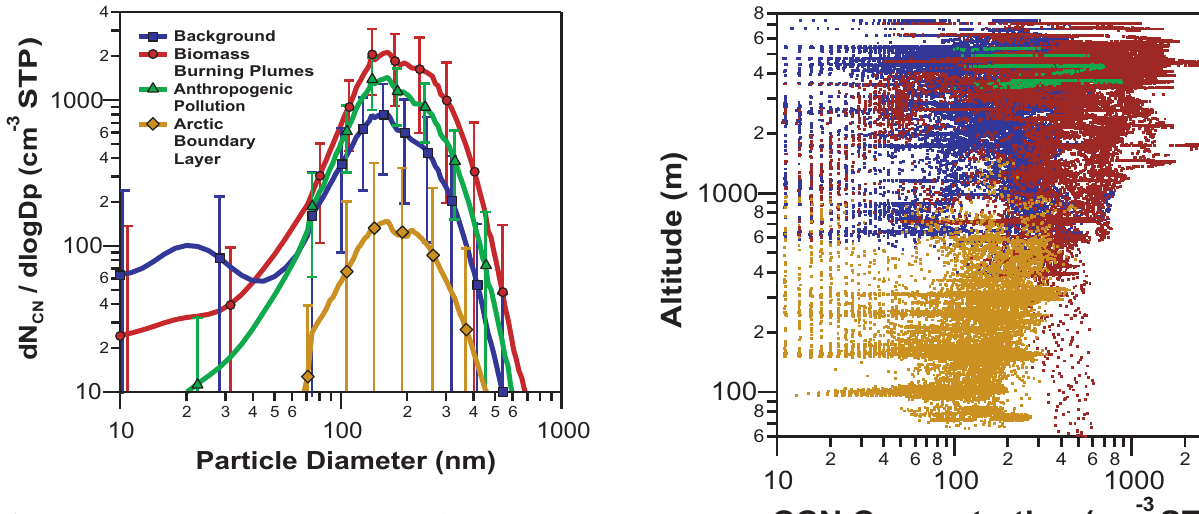
Fig. 2. Average dry particle size distributions for each air mass type sampled during 12–21 April. Error bars denote one standard deviation from the mean. Fig. 3. Vertical profiles of CCN concentrations measured during ARCPAC. Data shown are 1Hz measurements and are color-coded by air mass type as in Figs. 1 and 2.